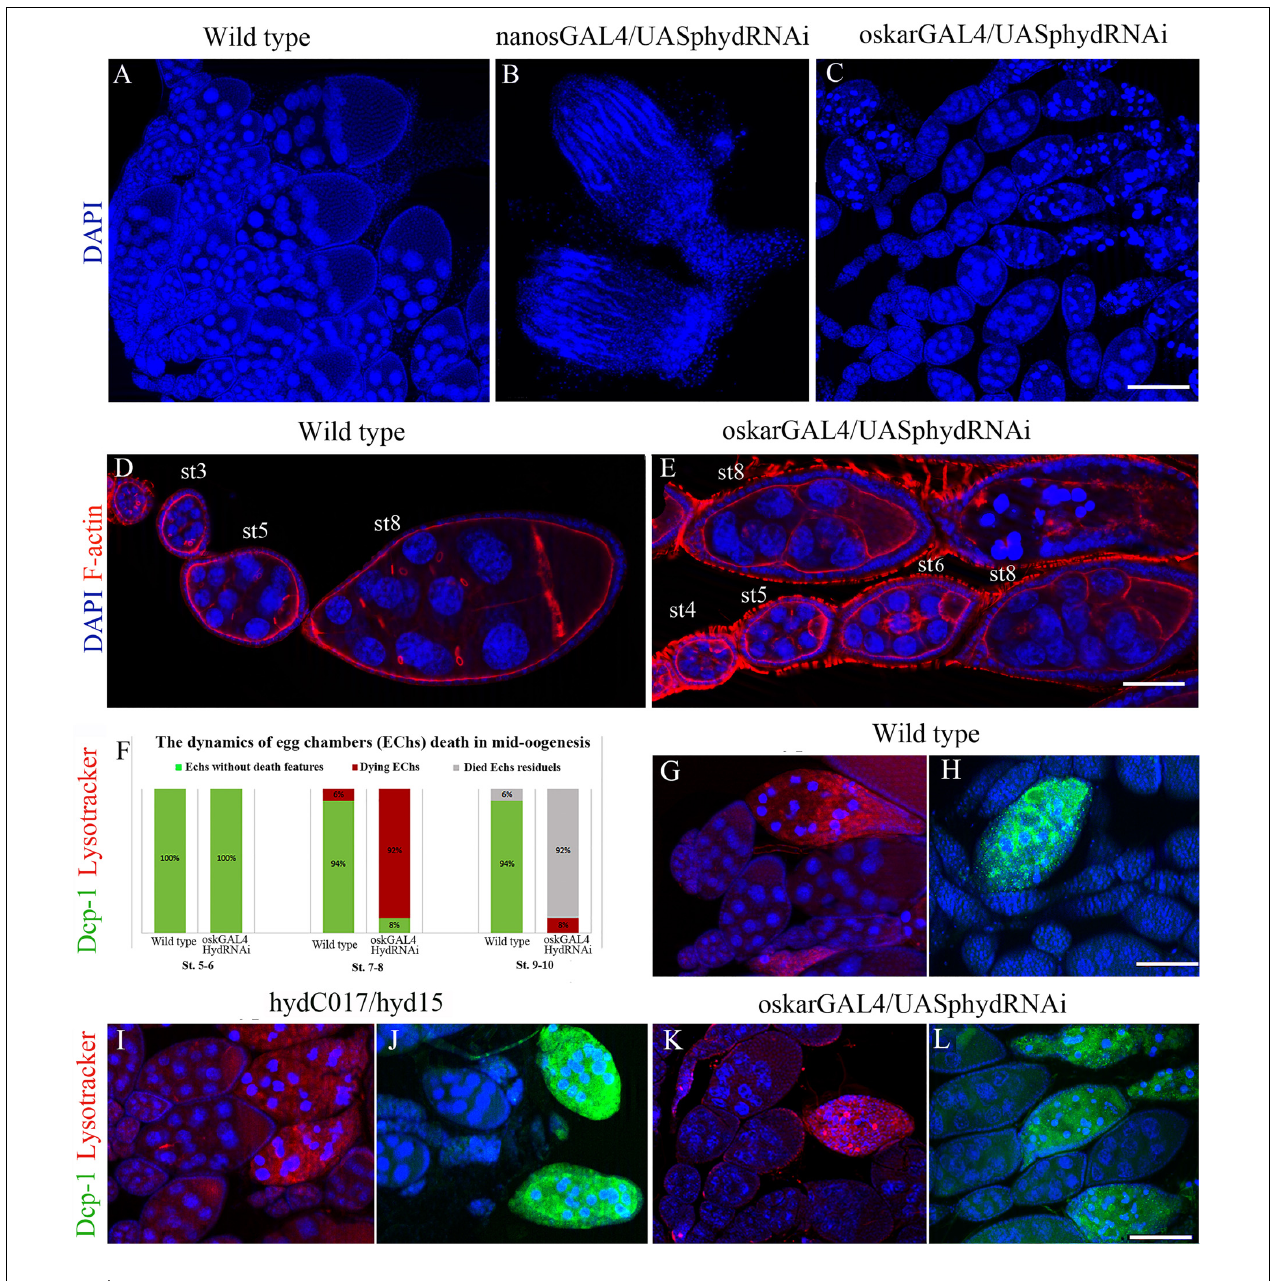
FIGURE 3 | Effects of the hyd RNAi knockdown on ovarian morphology and oogenesis. (A) Wild-type ovaries with normal ovarioles and EChs. (B) Reduced (somatic) ovaries of nanos-GAL4/UAS-hyd- RNAi females, lacking germ cells. (C) Mid-stage oogenesis arrest and massive ECh degradation in an oskar-GAL4/UAS-hyd -RNAi ovary. (D,E) Comparison of ovariole and ECh morphology at early oogenesis stages between a wild-type (D) and oskar-GAL4/UAS-hyd -RNAi ovary (E) . (F) Diagram representing a comparison of the number of dying egg chambers between the wild-type and oskar-GAL4/UAS- hyd-RNAi ovaries during the middle oogenesis. No. of examined ovaries – 50, for each type. (G–H) Cytological detection of lysosomal activity and effector caspase Dcp-1 in wild type, hydC015/hyd15 and oskar-GAL4/UAS-hyd -RNAi degrading EChs. Dying egg chambers of all types of ovaries